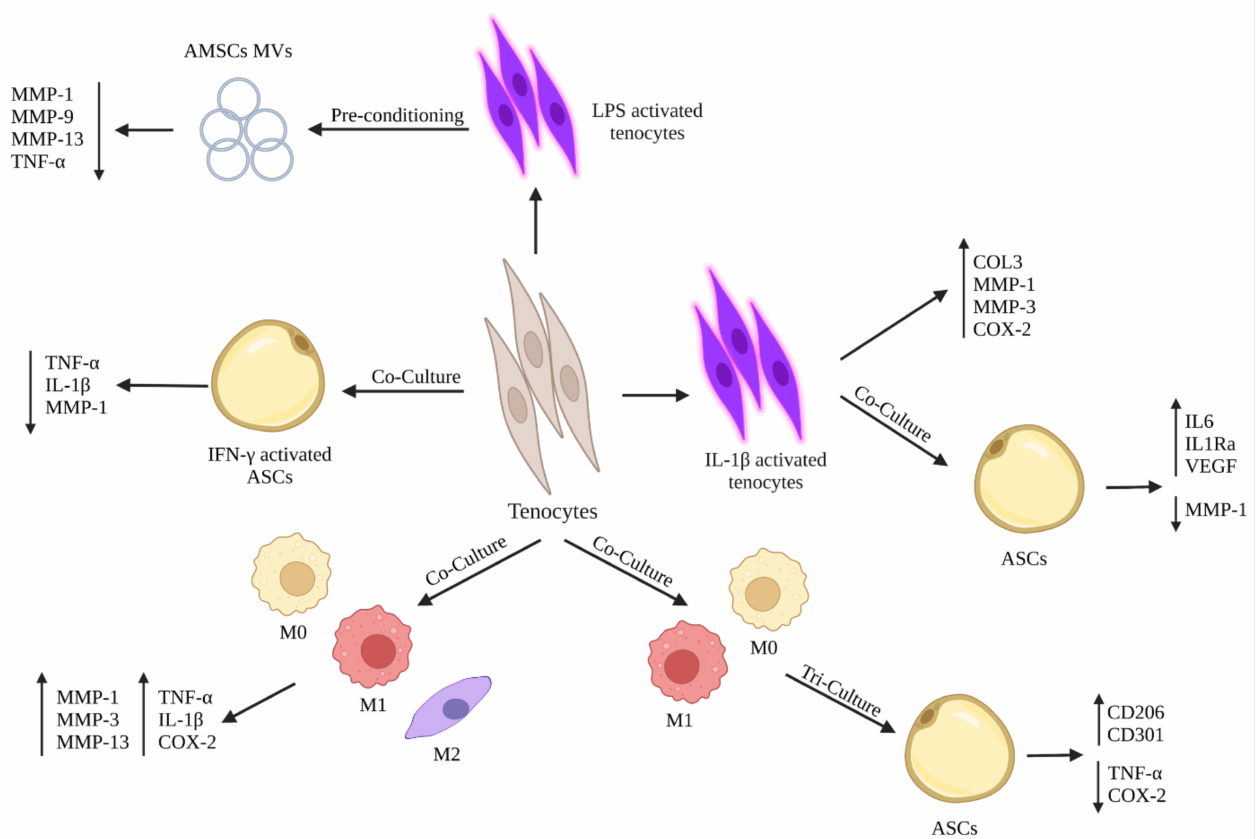
Figure 3. Schematic representation of the potential crosstalk between stem cells tenocytes on modu- lating tenocytes’ inflammatory responses in